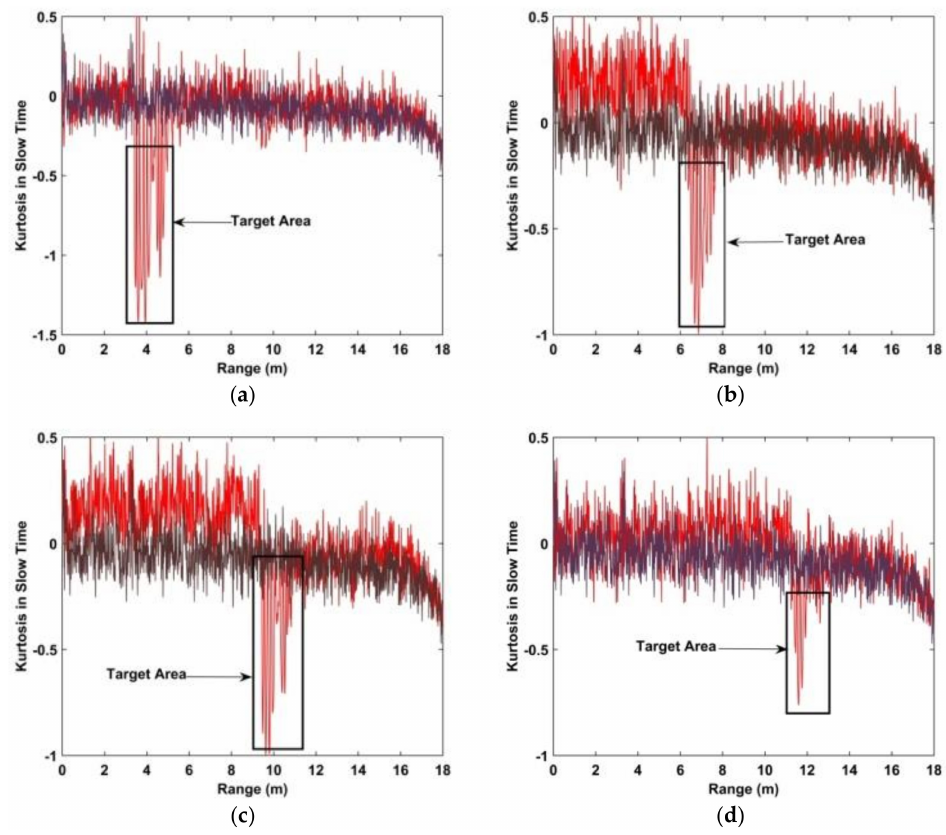
Figure 5. The kurtosis of the received signal with (red) and without (black) a human subject. The distances between the antenna and subject are ( a ) 300 cm, ( b ) 600 cm, ( c ) 900 cm, and ( d ) 1100